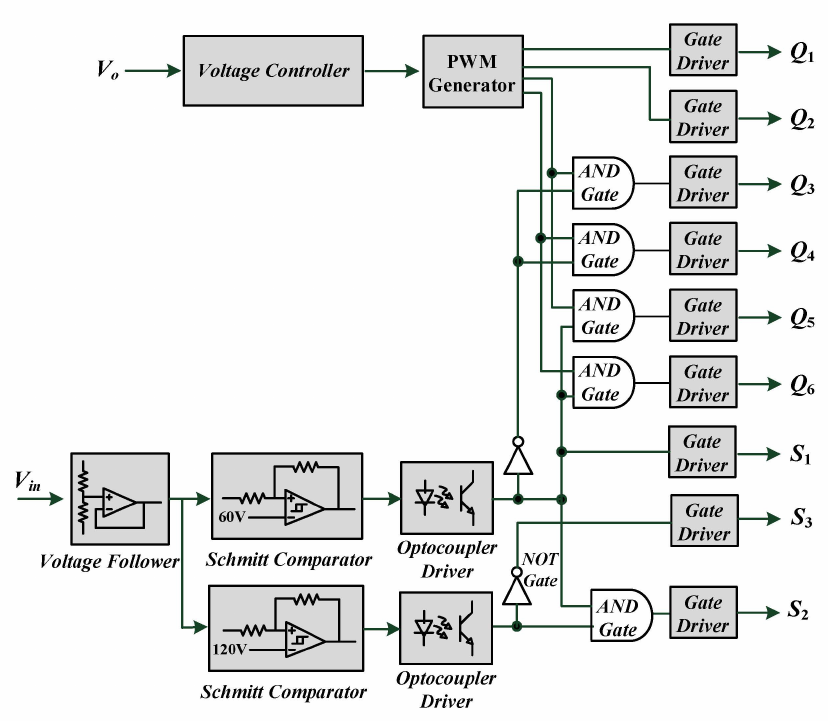
Figure 6. Control block of the studied